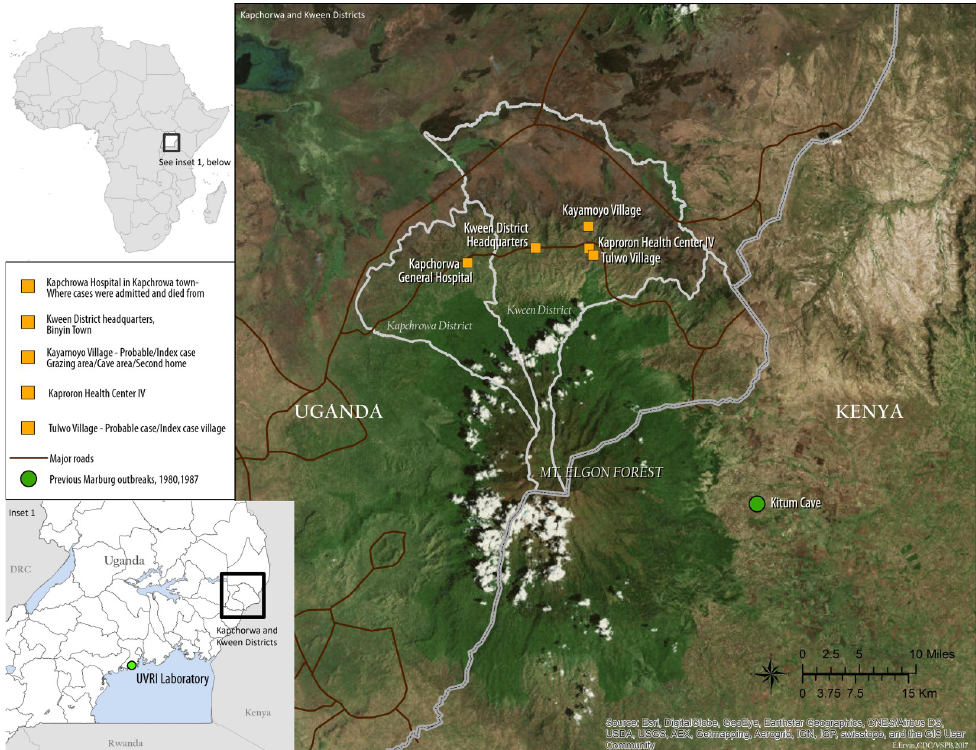
Fig 1. Map showing areas affected by the 2017 MVD outbreak. This figure was created specifically for this manuscript in ArcGIS using open source data from ESRI and DIVA-GIS for the background layers, and GPS points collected in the field for the points. (ESRI - http://opendata.arcgis.com/about,